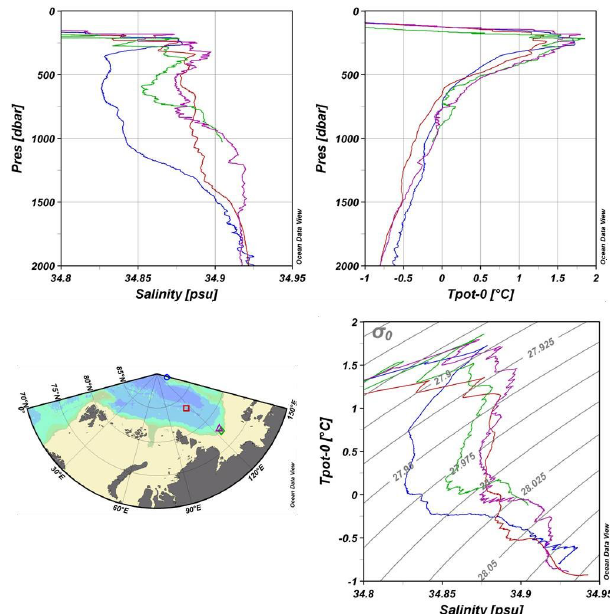
Fig. 23 . Profiles of salinity and potential temperature and θS curves showing different eddies observed on the SPACE cruise 2007. Es- pecially the 800-m-thick eddy of Barents Sea branch water found in the intra-basin in the central Lomonosov Ridge (blue station) is